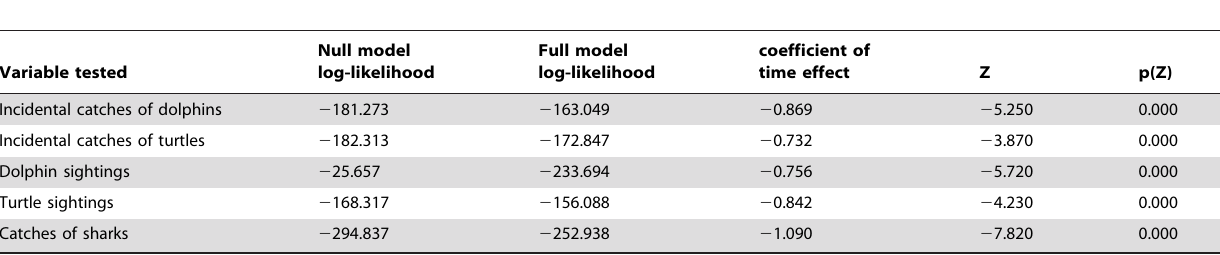
Table 4. Results of the Generalized Linear Mixed Models on ordinal outcomes combining all cases